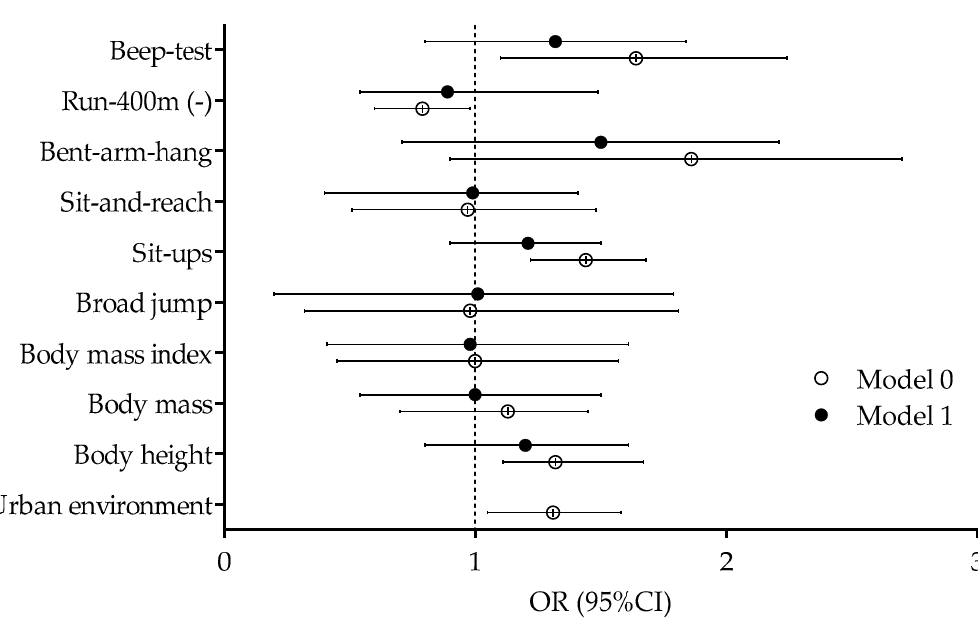
Figure 4. Predictors of normal physical activity levels at follow-up (Model 0 – crude logistic regression, Model 1 – logistic regression controlled for urban/rural environment as confounding factor).